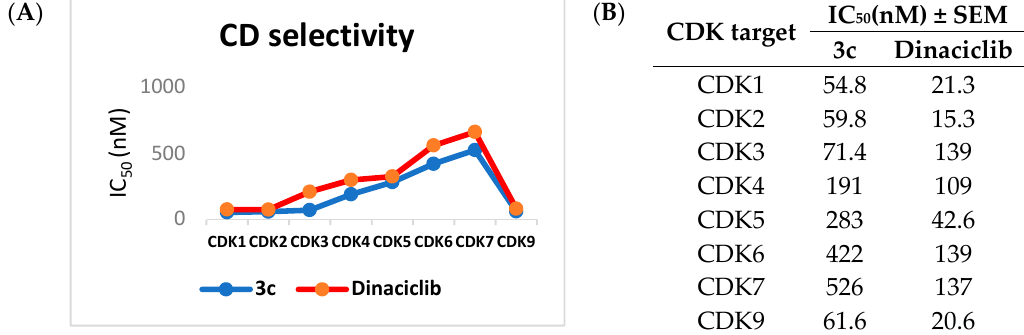
Figure 6. Selectivity profiling of compound 3c and Dinaciclib. ( A , B ) Biochemical testing of 3c against CDK isoforms on the SK-MEL-5 cell line. All data were obtained by triplet